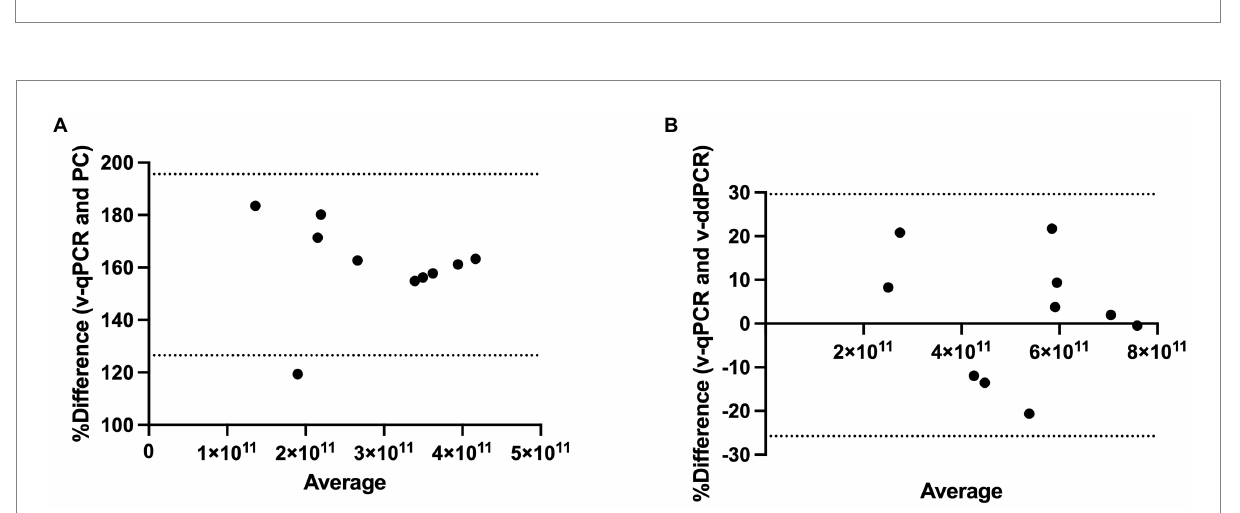
FIGURE 6 Method agreement analysis for L. paracasei 8700:2 viability real-time PCR method with plate count and viability droplet digital PCR methods. (A) Bland–Altman method comparison (difference versus average analysis) for viability real-time PCR (v-qPCR) method and plate count (PC) method (Relative difference ranging from 119 to 184%). (B) Bland–Altman method comparison (difference versus average analysis) for viability real-time PCR (v-qPCR) method and viability droplet digital PCR (v-ddPCR) method (Relative difference ranging from − 20 to 22%).